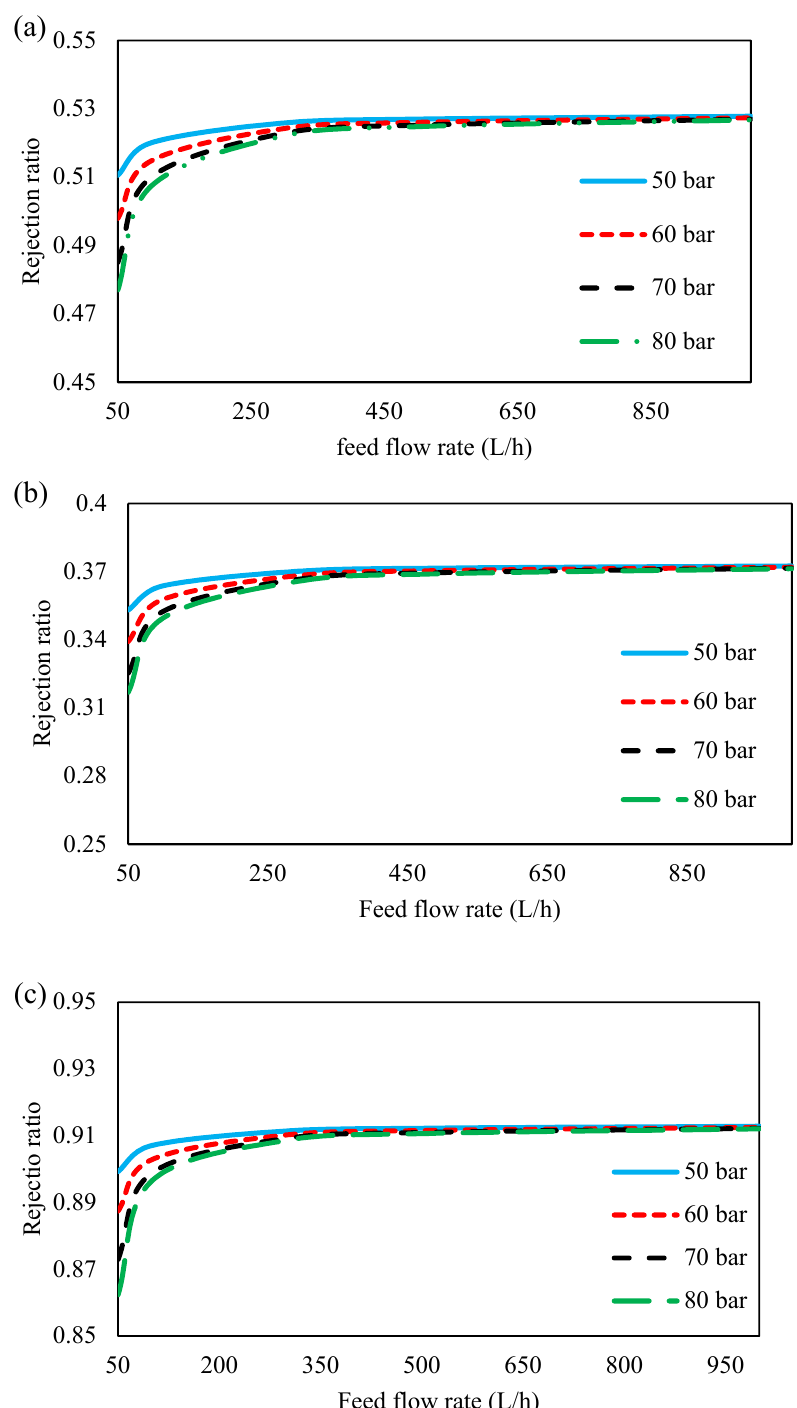
Figure 13. Rejection rate for ( a ) formate, ( b ) acetate, ( c ) sulfat, of 45 wt. % MDEA solution at different inlet feed pressures and feed flow rates.